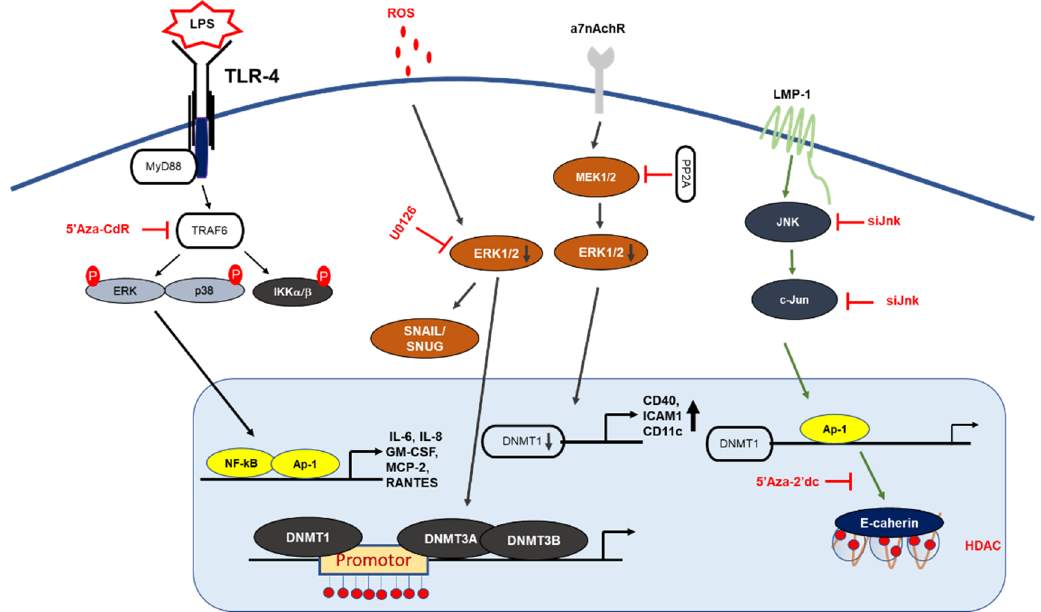
Figure 2. MAPK signaling mechanism by DNA methylation. LMP1 induction of DNMT1 results in hypermethylation of E-cadherin promoter: LMP1 activates the signaling of AP-1, which then binds to the DNMT-1 promoter, leading to hypermethylation of the E-cadherin gene. Deletion of the DNMT1 component increases LPS-induced cytokine expression in NF- κ B and AP-1 signaling. PP2A dephosphorylates MEK1/2 and inhibits the activity of DNMT1, leading to the hypomethylation and increased expression of CD70 and CD11a. In T-cells, 5-Aza-Cdr treatment significantly increased the gene expression levels of cytokine IL-6, IL-8 GM-CSF, MCP2, and RANTES, and resulted in the upregulation of ERK phosphorylation.